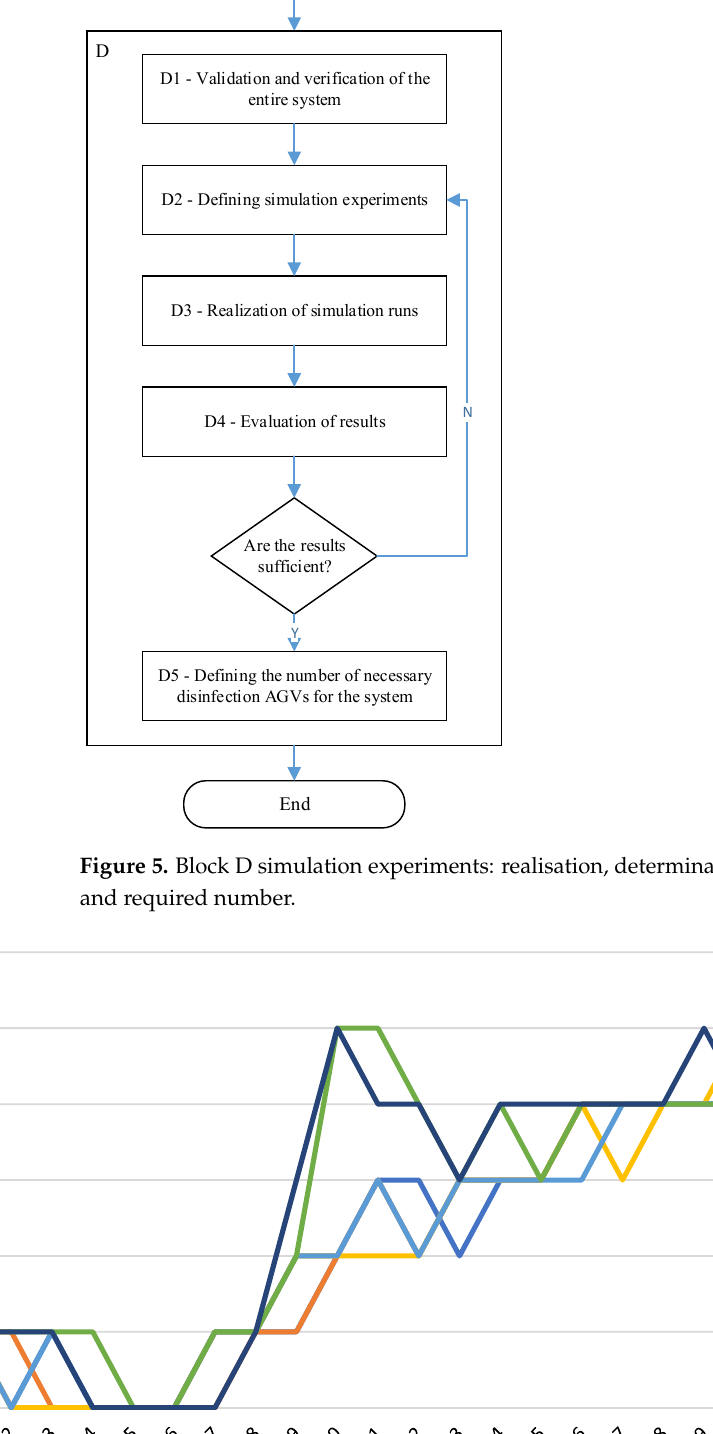
Table 1 . Duration of treatment at each workplace. Patient Logic Type of Patient Acute